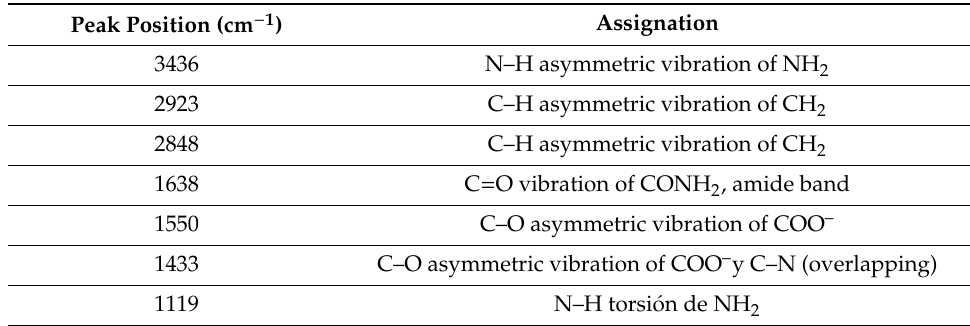
Table 1. Characterization of polyacrylamide (PAM) bands through Fourier transform infrared (FTIR).